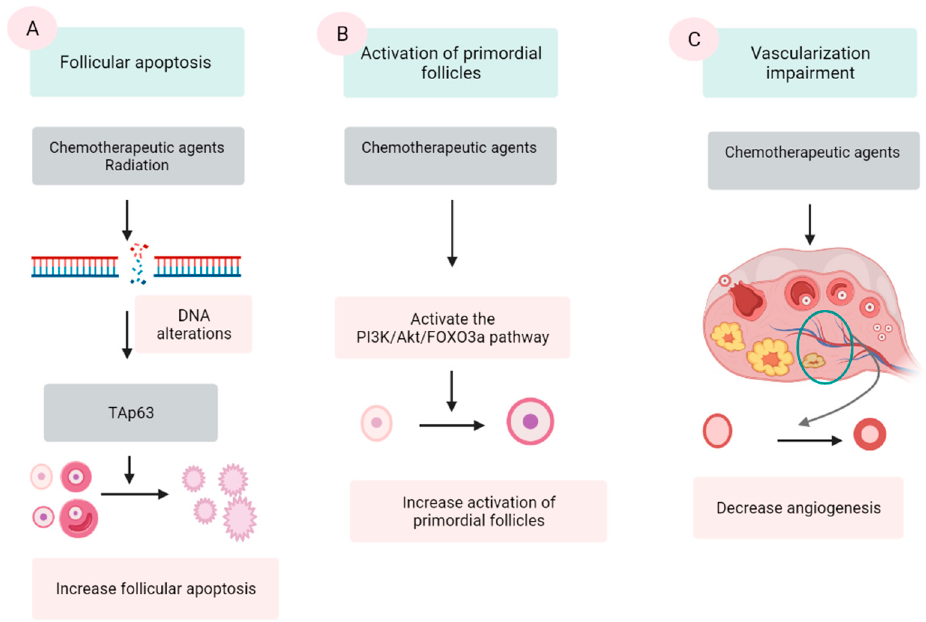
Figure 1. Three mechanisms of chemo- and radio-therapy-induced follicular quantity depletion: enhancement of apoptosis, accelerated activation of PFs. ( A ) DNA alterations induced by chemotherapeutic agents and radiation activates TAp53 protein, leading to the apoptosis. ( B ) Chemotherapeutic agents activate the phosphoinositide 3-kinase (PI3K)/Akt/forkhead box protein O3a (FOXO3a), which in turn induce the activation of PFs, resulting in the extensive loss of PFs. ( C ) Chemotherapeutic agents impair the epithelial tissue of vessels in the ovary, resulting in a reduction in the vas- cularization.